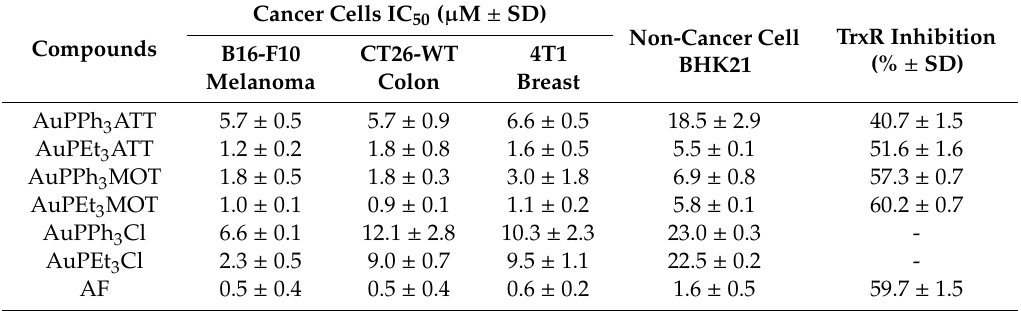
Table 1. Antiproliferative activities of Au(I) complexes against cancer cell lines and inhibition at 5 µ M of TrxR activity [104].